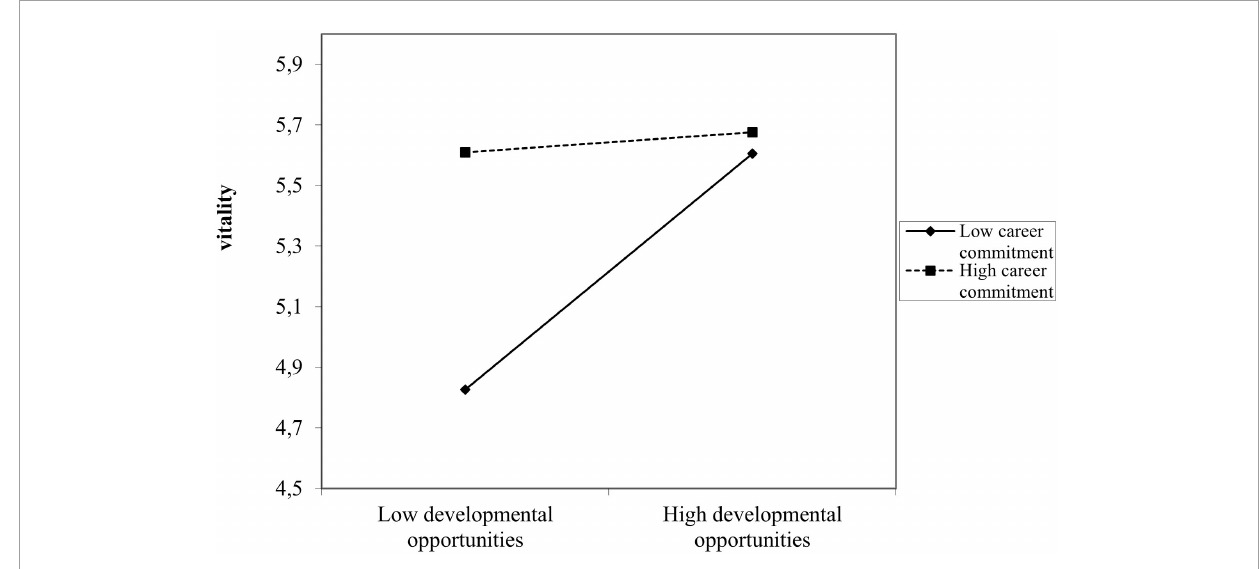
FIGURE2 Two-way interactive effect of developmental opportunities with career commitment for